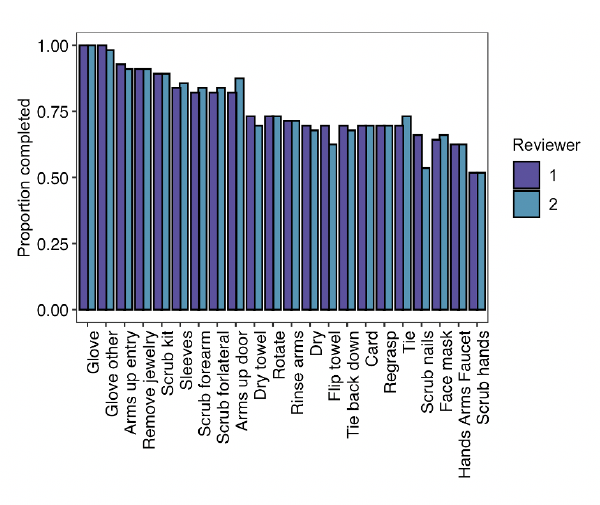
Figure 2. Proportion of Participants that Completed Checklist Items (as Evaluated by Reviewers).